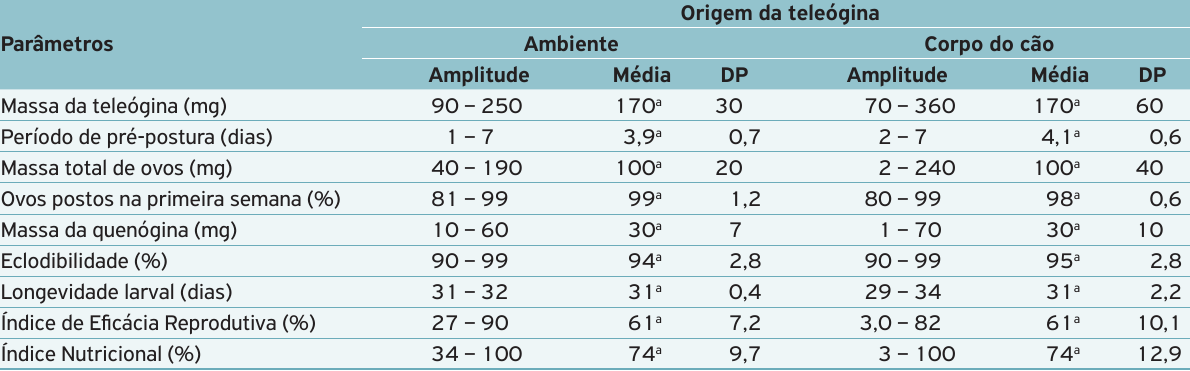
Tabela 1. Parâmetros biológicos de R. sanguineus naturalmente desprendidas e coletadas do corpo do hospedeiro, com dados referentes à amplitude, à média e ao desvio